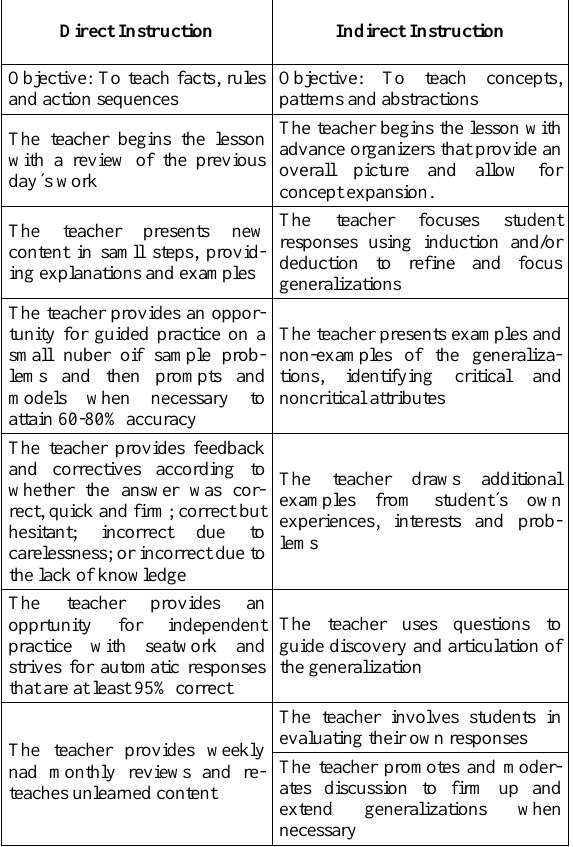
TABLE I. E XAMPLES OF OF D IRECT AND I NDIRECT I